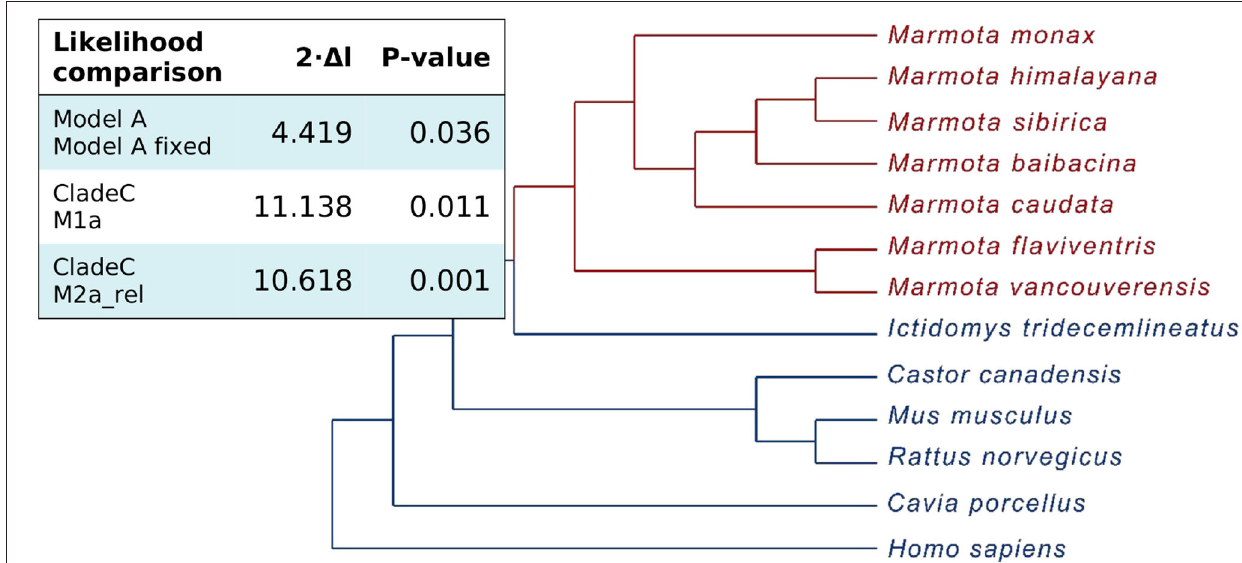
FIGURE 2 | Results of branch-site model comparisons for SIRT1 protein coding genes with a cladogram of the phylogenetic relationship of the species used for analyses, divided into A: marmot clade (red) and B: other mammalian species (blue).